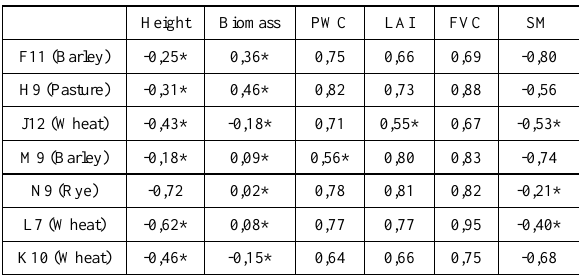
Table 1. Correlation (R Pearson) between field estimations and NDVI. Non-significant correlations at 95% confidence level are indicated by